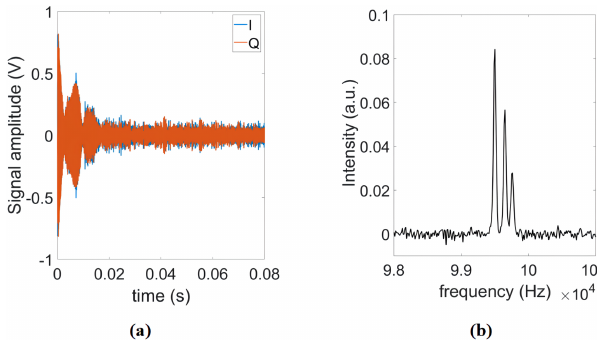
Figure 8. (a) Single-shot FID of ethanol. (b) Real part of the cor- responding Fourier